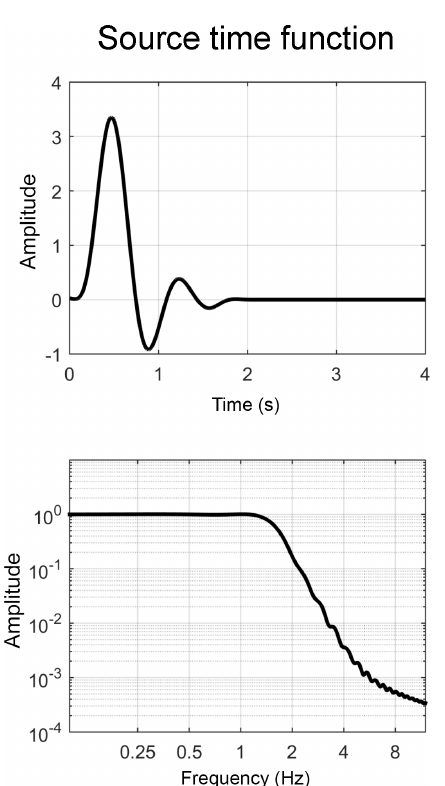
Figure 7. The time series and corresponding amplitude spectrum of the source time function used to excite the numerical